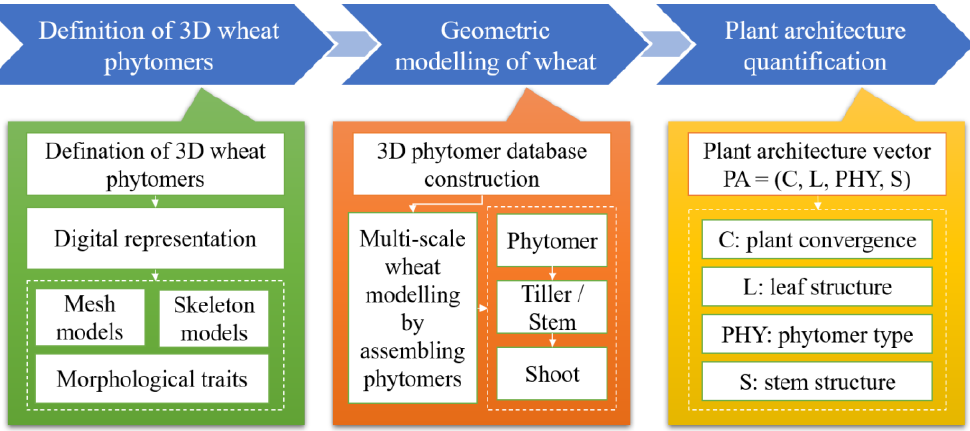
Figure 2. Overview of 3D phytomer-based geometric modeling and plant architecture quantifica- tion of wheat. of